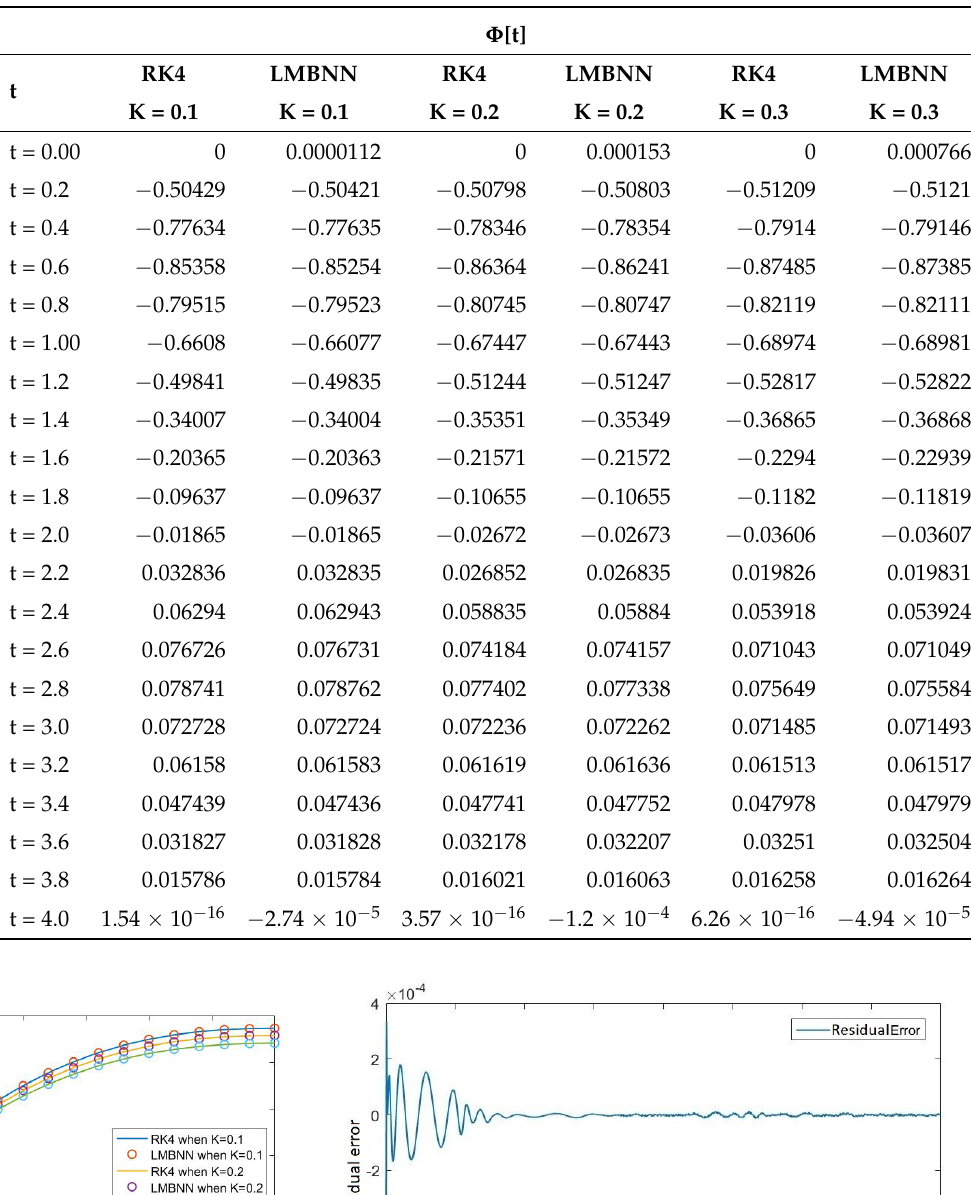
Table 6. Different outputs of Φ using different values of rotation parameter K by solving on RK4 and LMBNN.